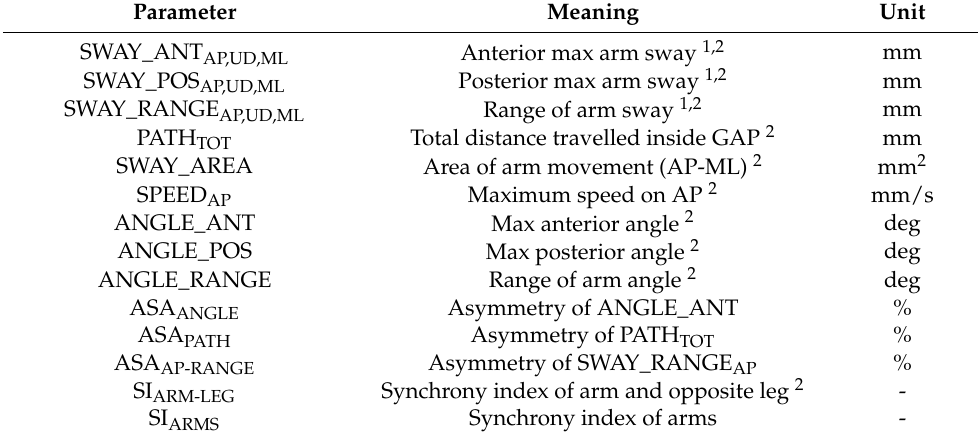
Table 1. Parameters related to arm swing.